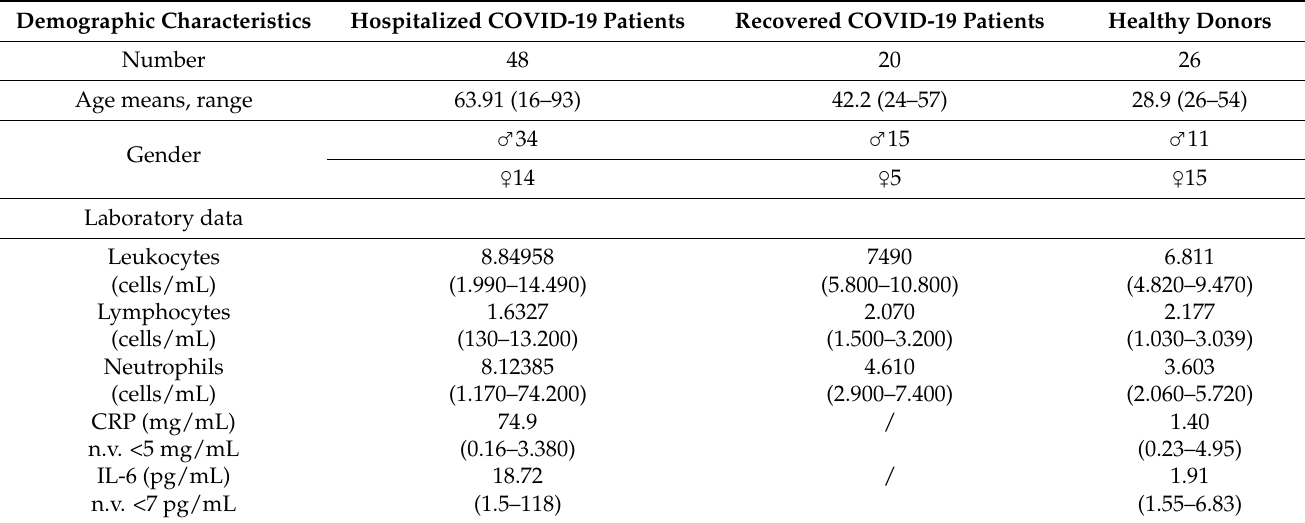
Table 1. Demographic and clinical characteristics of the cohorts under